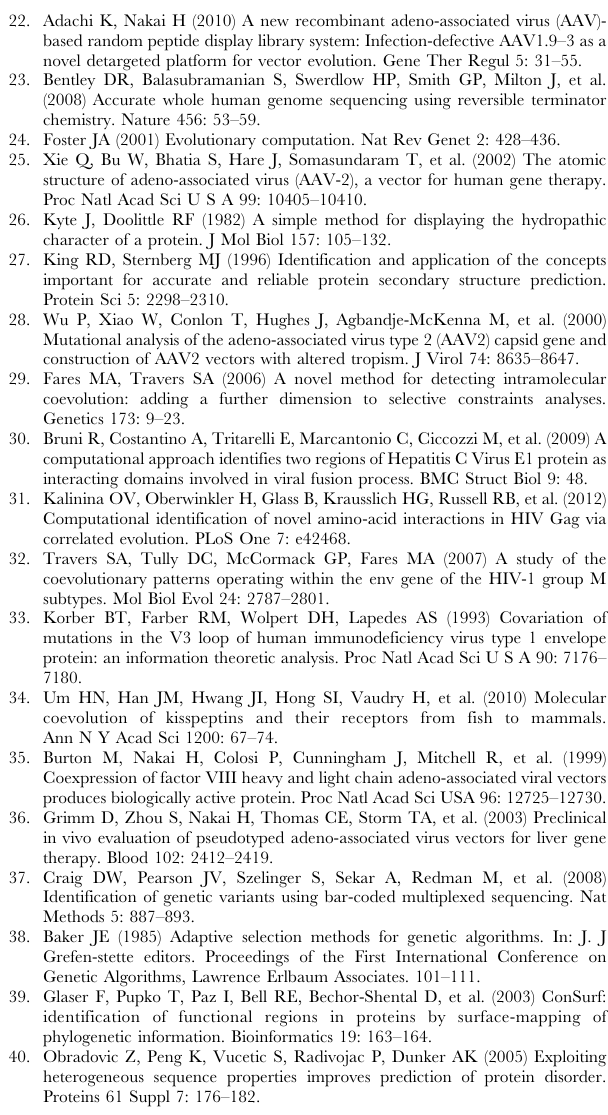
Table S7 VP and AAP amino acid matrices used for the evolutionary algorithm. Table S8 Cut-off values for sub-penalty